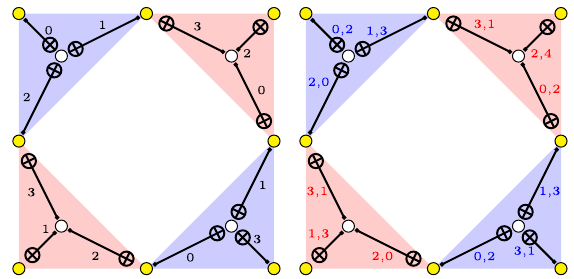
FIG. 10. Parity-check measurement schedule for the subsystem surface code using a homogeneous ð ZX Þ r sequence (left) [34], a homogeneous Z r sequence (right, blue text), and a homogeneous X r sequence (right, red text). CNOT gates are labeled with the time step(s) they are applied in, which are given modulo 4, since all schedules have period